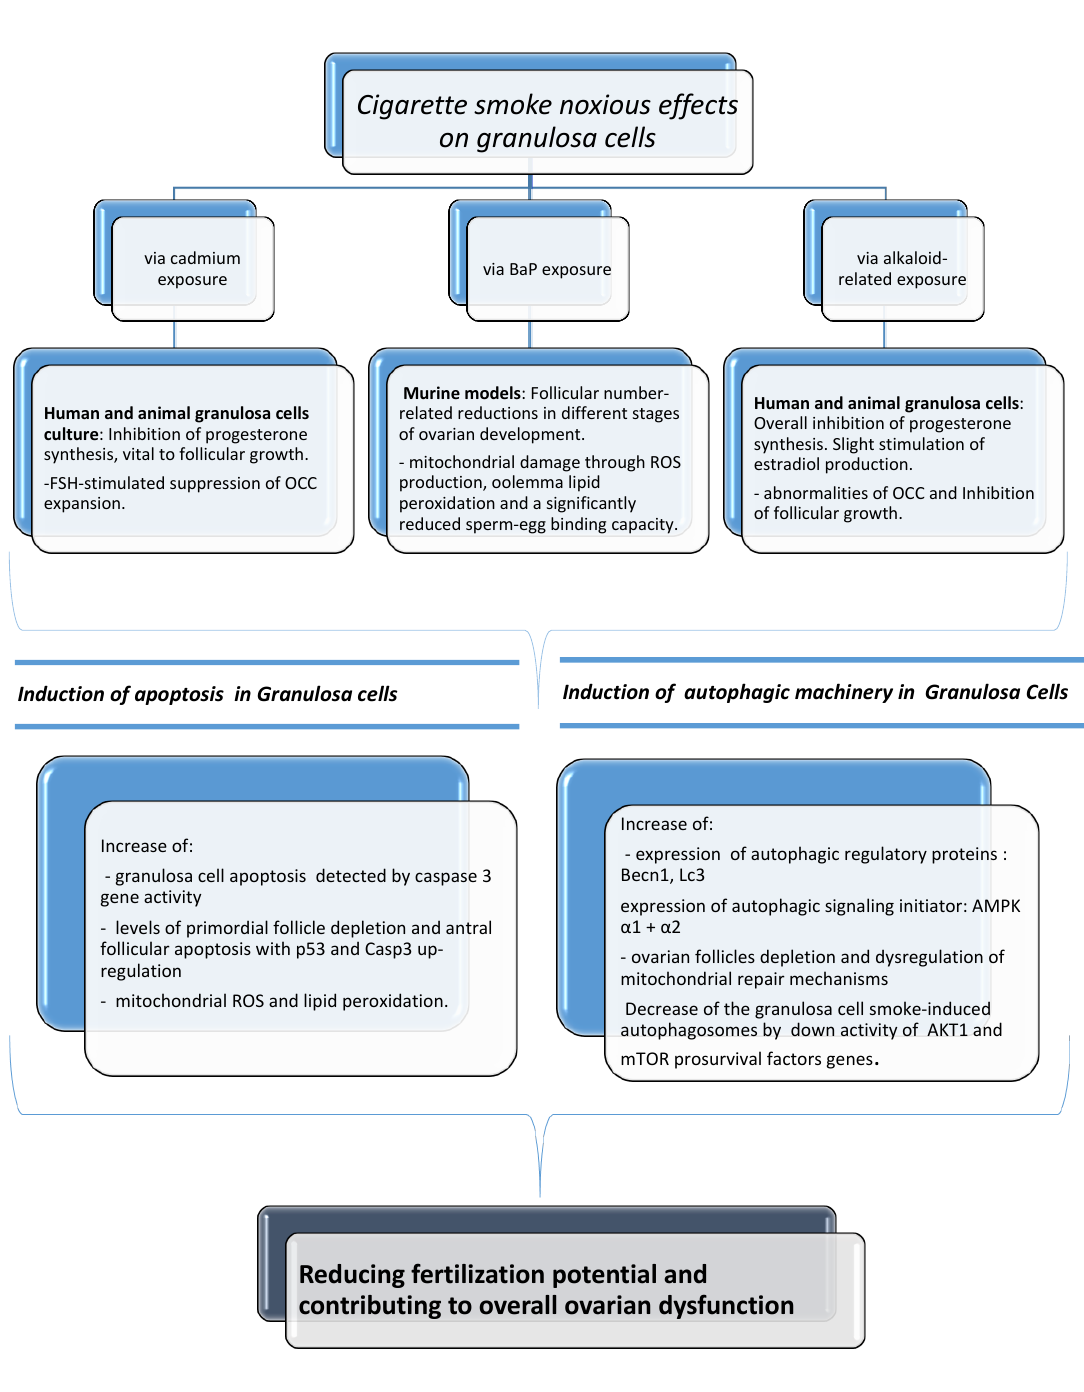
The noxious e ff ects of cigarette smoke in mammal granulosa cells via cadmium, Figure 4. The noxious effects of cigarette smoke in mammal granulosa cells via cadmium, BaP, and BaP, and alkaloid-related exposure and relative molecular pathways alkaloid-related exposure and relative molecular pathways involved.